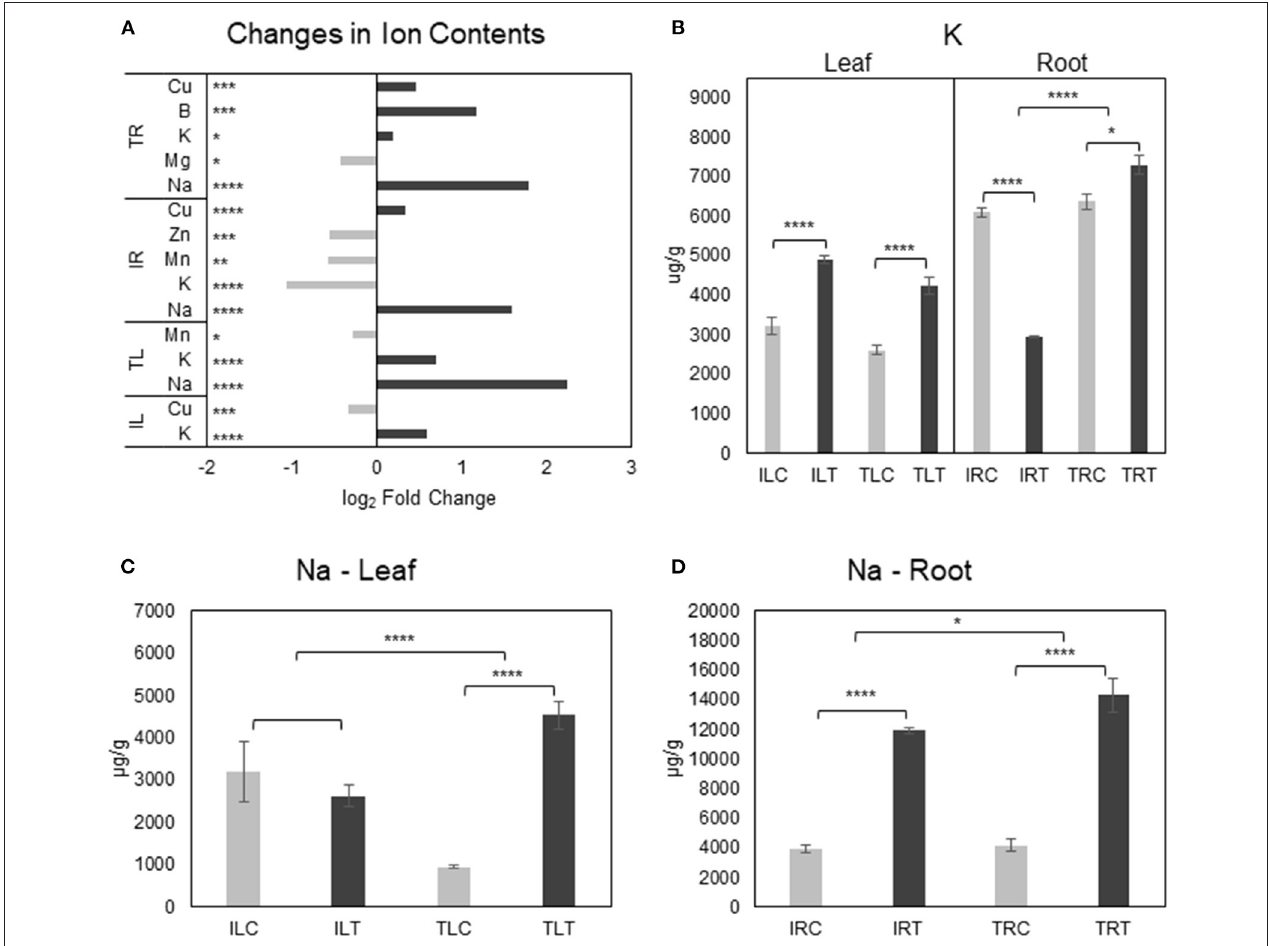
FIGURE 7 | Salt responsive ion content changes for tissues and genotypes (A) . K + (B) and Na + (C,D) content changes were also displayed separately to emphasize the difference in changes between genotypes (C, control; T, salt treatment). Comparison of other ions can be found in Supplementary Figures 3 , 4 . * indicates significance and quantity of * displays the level of significance. (* p < 0.05; ** p < 0.01; *** p < 0.005; **** p <